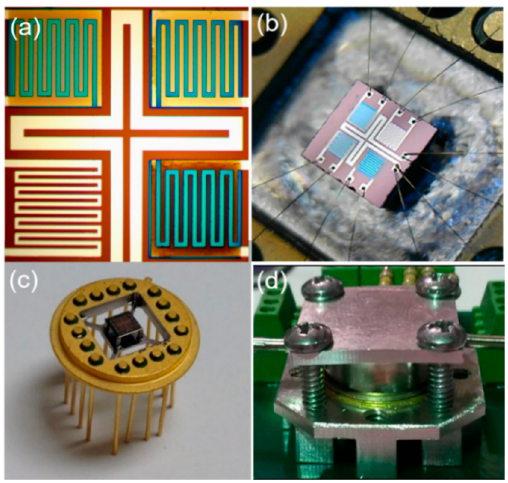
Figure 1. Optical images of the ( a ) multi-sensor platform, the ( b,c ) multi-sensor platform mechanically and electrically attached to a transistor outline (TO) electronic package, and the ( d ) gas chromatography (GC) multisensory detector in the flow-chamber.